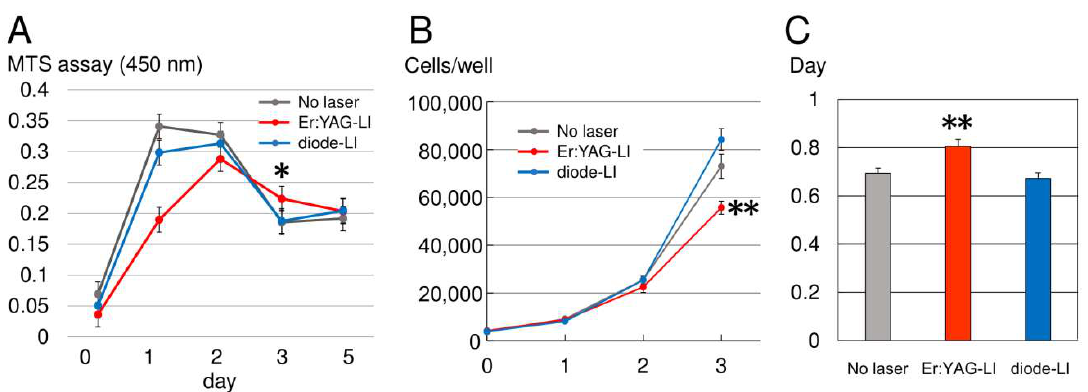
Figure 1. Effect of laser irradiation (LI) on PPU-7 proliferation incubated for different periods. ( A ) MTS assay. PPU-7 after Er:YAG-LI (red), diode-LI (blue), and without LI (grey) on day 0, 1, 2, 3, and 5, were cultured at a final volume of 120 μL/well for 1 h at 37 °C. MTS reagent was added, and an absorbance of 450 nm was recorded using a microplate reader ( n = 10 tests per sample). Values are the mean ± standard error (* p < 0.01, Steel’s test). ( B ) The number of PPU-7 cells. PPU-7 cells were counted on day 0, 1, 2, and 3 after laser irradiation (** p < 0.05, Steel’s test). ( C ) Cell population doubling level against days after laser irradiation. Data are means ± standard error (** p < 0.05, Steel’s test).